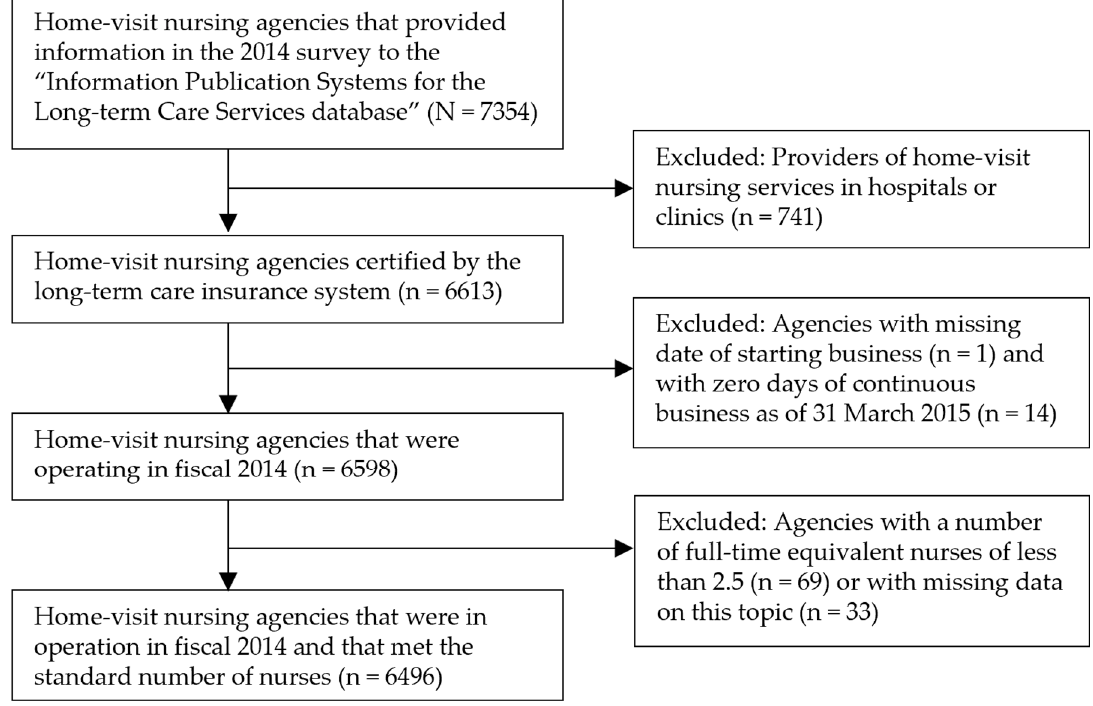
Figure 1. Flow chart of the process of selecting home-visit nursing agencies.